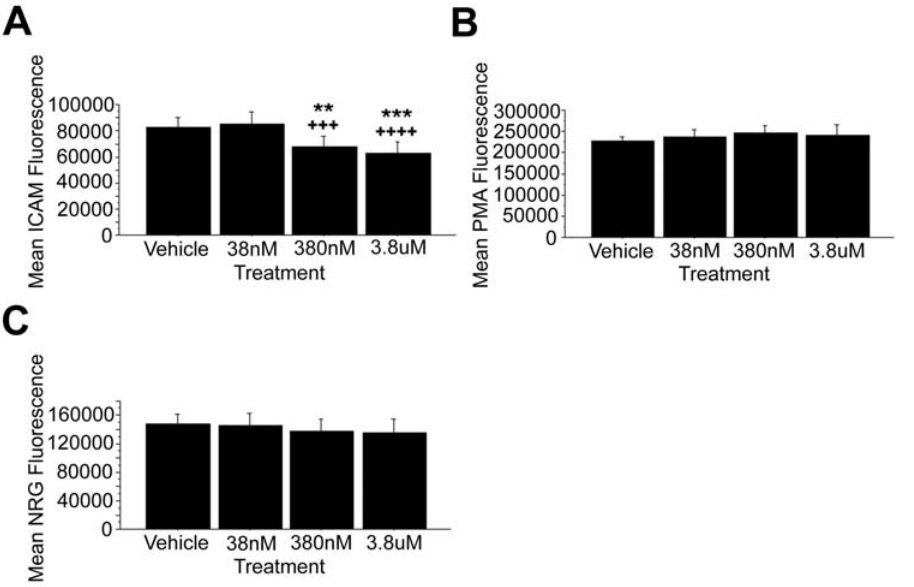
Figure 7. Myosin light chain kinase (MLCK) is important for baseline attachment. Administration of the MLCK inhibitor ML-7 in DMSO vehicle (n=5) caused a significant reduction in baseline attachment at the middle and high doses (A) . Although this was associated with increases in mean NRG/vehicle and mean PMA/vehicle (not shown), these effects were merely a consequence of reductions in the denominator as both the raw PMA (B) and NRG (C) fluorescence values were unchanged. Compared with the vehicle control, ** represents p , 0.01 and *** represents p , 0.001. Compared with the low dose, +++ represents p , 0.001 and ++++ represents p , 0.0001.